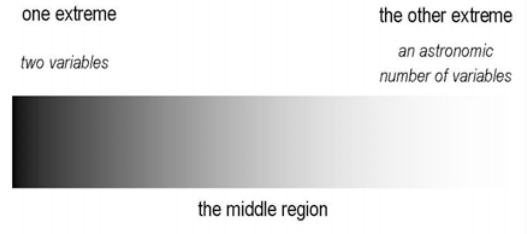
Fig. 6. Weaver’s trichotomy of scientific